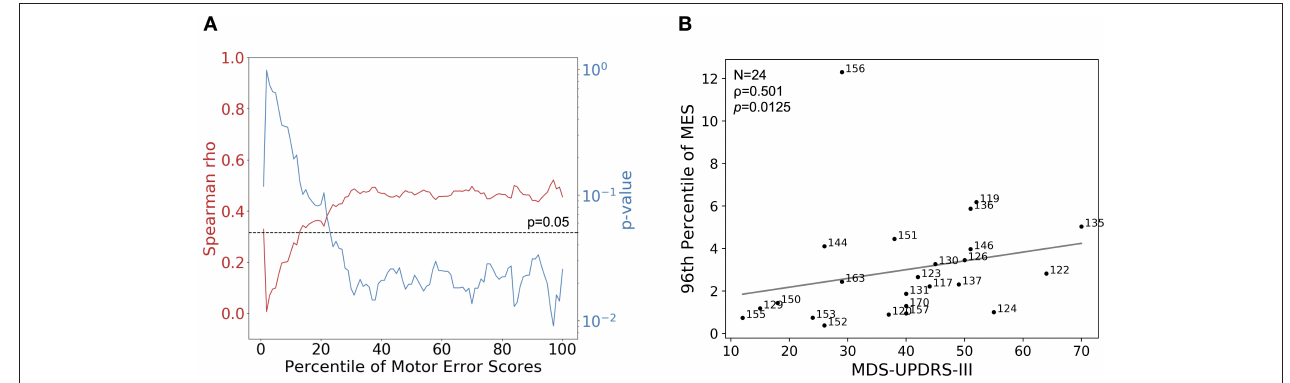
FIGURE 2 | Correlations of MES with MDS-UPDRS-III. (A) Using MDS-UPDRS-III, Spearman’s correlation coefficient (red line) and corresponding p -values (blue line) were calculated using percentiles between 0 and 100 of session-wide MES for each patient. Higher percentiles correspond to progressively smaller fractions of higher-valued MES. The dotted line indicates a p -value of 0.05, the selected alpha-level in this analysis. In general, better correlations between MES and MDS-UPDRS were observed when considering patients’ epochs of more prominent motor dysfunction; the maximum correlation and lowest p -value occurred at the 96 th percentile of MES. (B) MDS-UPDRS-III (Motor Examination subsection) scores plotted with corresponding 96 th percentile session-wide MES for 24 patients with PD for which MDS-UPDRS-III scores were available. Strength of association was determined by calculating Spearman’s correlation coefficient ( ρ = 0.501, p =